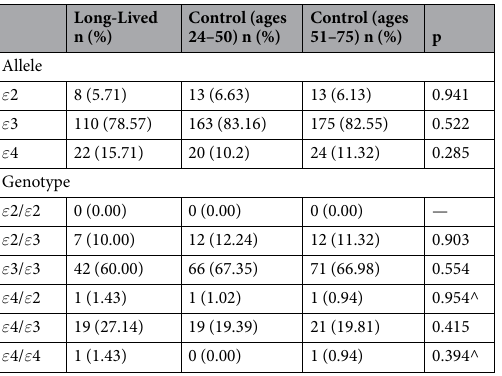
Table 2. Frequencies of APOE Alleles and Genotypes in Long-Lived Individuals and Controls. ^ Fisher’s exact test was used; Pearson’s χ 2 test was used for the